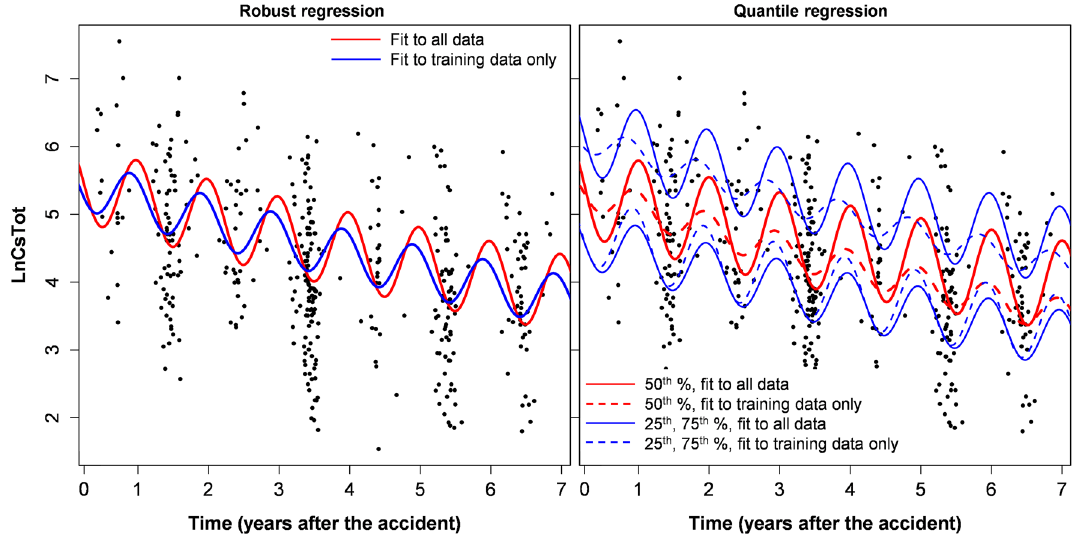
Figure 3. Robust and quantile regression analyses for Asian black bear ( Ursus thibetanus ) data. This figure was generated using R 4.0.3 software 21